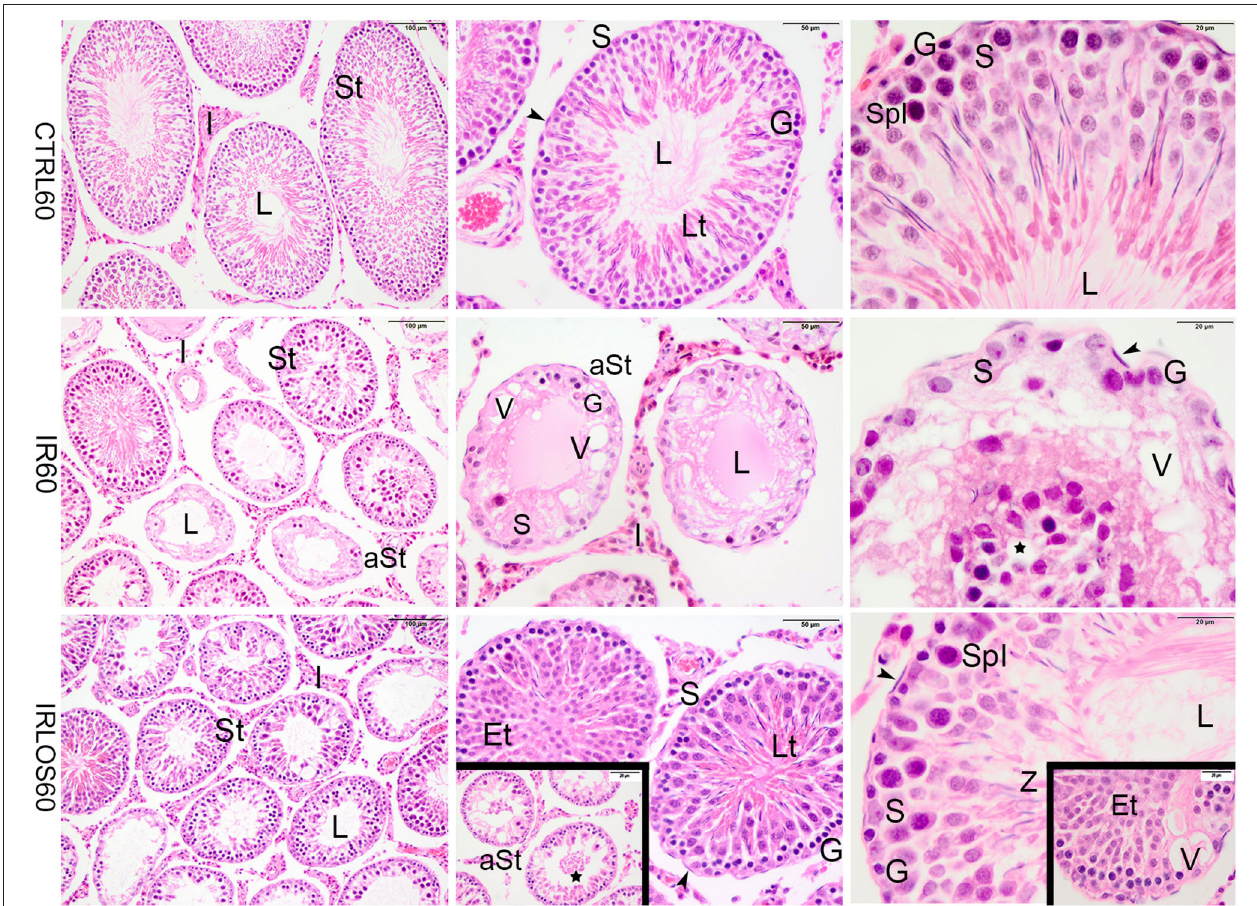
FIGURE 2 | Representative photomicrographs of the testis from control (CTRL 60), irradiated (IR 60), and irradiated and treated with losartan (IRLOS 60) groups 60 days after the exposure, stained with hematoxylin and eosin. In the control group, the testis exhibited a classic morphology and normal seminiferous tubules (St), lined by Sertoli cells (S), with germ cells in different stages of development. In the irradiated group, seminiferous tubules exhibited damage signal irradiation, characterized by loss of germ cells (*), presence of vacuoles (V), atrophied seminiferous tubules (aSt), and sloughing of cells into the lumen ( ⋆ ). Note the Sertoli cells and spermatogonia were the unique surviving cells in the seminiferous epithelium. In the irradiated and treated group, seminiferous tubules in recovering were observed with scattered degenerated tubules. The recovery tubules exhibit seminiferous epithelium with germ cells in advanced stages of spermatogenesis. Et, early spermatids; G, spermatogonia; Lt, late spermatids; L, lumen; SpI, primary spermatocytes; Z, sperm; ◮ , peritubular myoid cells; Scale bar, first column (100 µ m); second column (50 µ m); and third column and insets (20 µ